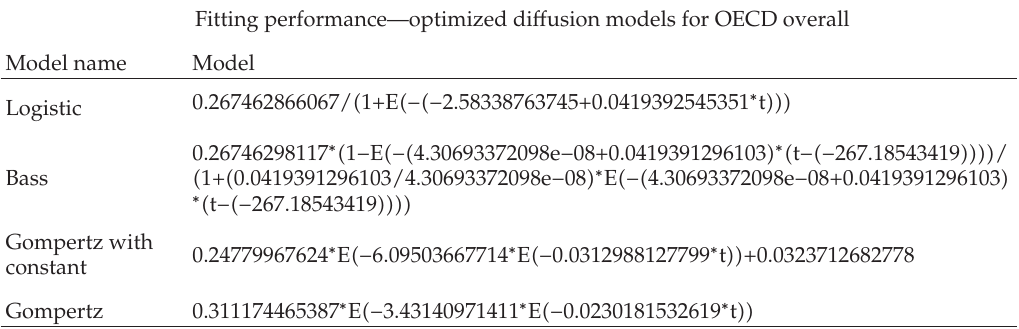
Table 22: Representation of the optimized di ff usion models in fitting (cid:2) OECD overall (cid:3) . Fitting performance—optimized di ff usion models for OECD overall